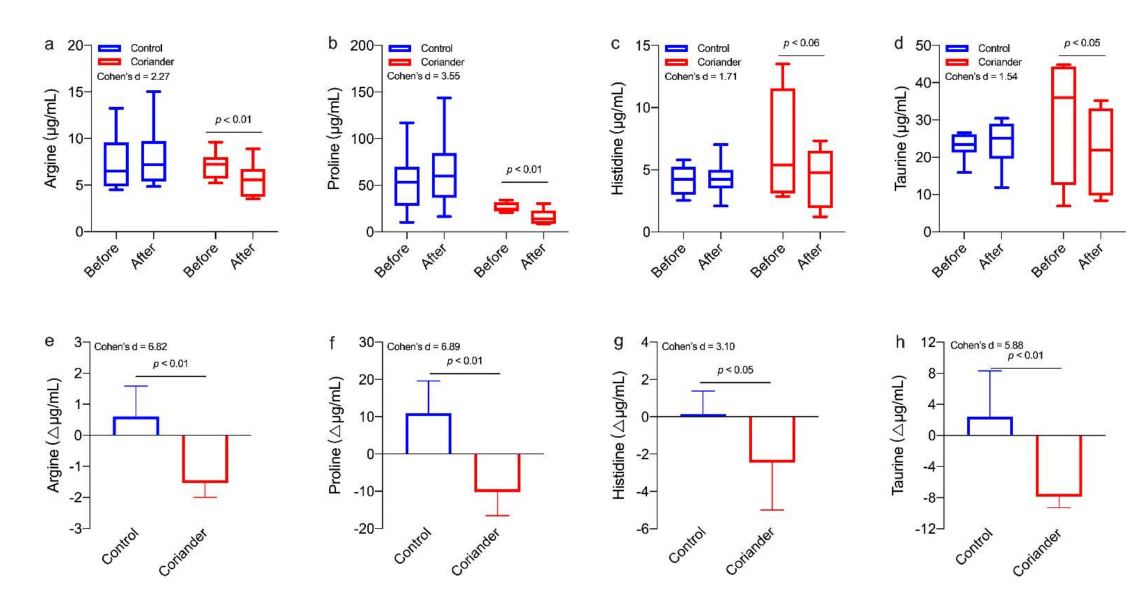
Figure 6. ( a ) Comparison of different salivary amino acids before and after the homework ( ∆ µ g/mL). Similar results were shown in ( b – d ). Paired t -tests were used to identify the significant differences before and after homework in the same group. ( e ) Changes in salivary metabolomics between the coriander and control groups ( ∆ µ g/mL). Similar results were shown in ( f – h ). Independent t -tests were used to identify the significant differences between the two groups. Data presented as variation ± standard error ( n = 6).